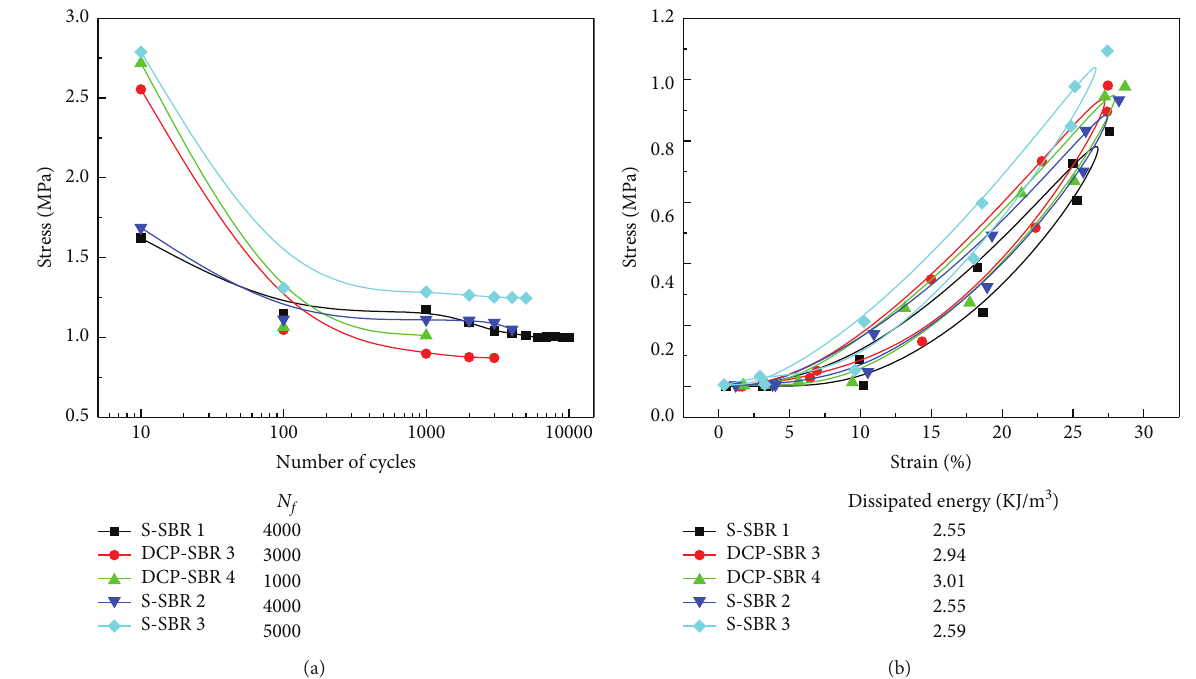
Figure 3: S-N curves (a) and dissipated energy (b) of five different samples with the same crosslinking density degree but different types of